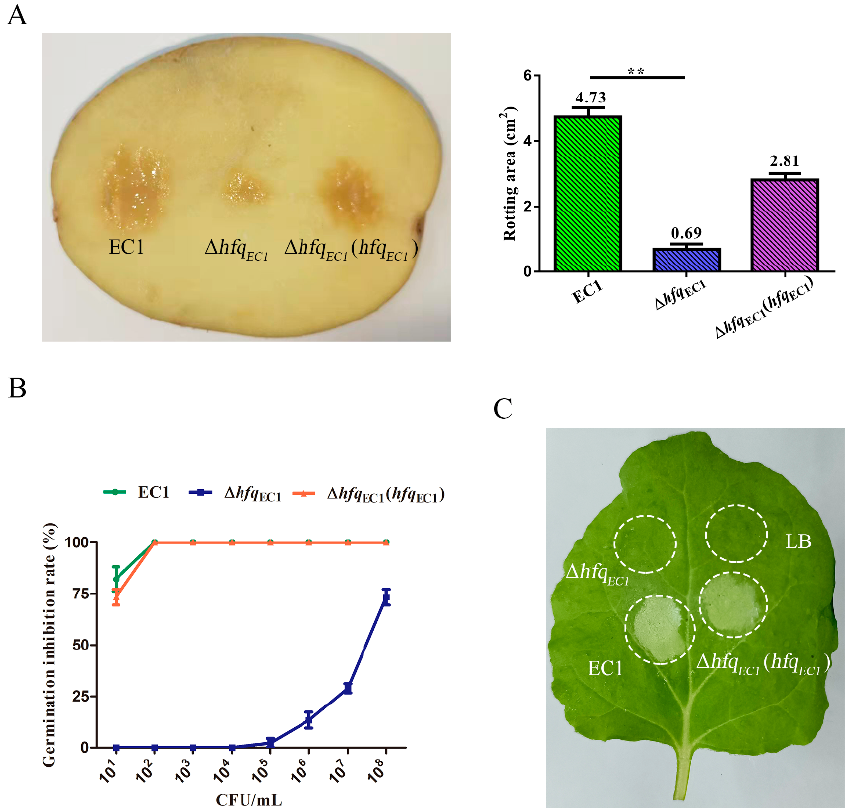
Figure 5. Hfq EC1 is required for the virulence and hypersensitive response (HR) in Dickeya oryzae EC1. ( A ) Disease symptoms (left) and the rotting areas (right) on potato tubers inoculated with wild-type strain EC1, hfq EC1 mutant, and complementation strain of hfq EC1 mutant. Photograph was taken 2 d after inoculation. The numbers at the top of each column show the average rotting area ± SD from three repeats. ** p < 0.01. ( B ) Analysis of the capacity of D . oryzae EC1 in inhibiting rice seed germination. Rice seeds were treated with different bacterial dilutions as indicated and incubated at 28 °C for 7 days. Experiments were individually performed at least three times in triplicate. ( C ) The hypersensitive response induced by wild-type strain EC1, hfq EC1 mutant, and complementation strain of hfq EC1 mutant on leaves of Nicotiana benthamiana . An aliquot of 5 µL of bacterial cell cultures (OD 600 = 0.05, 2.0 × 10 4 CFU/mL) was inoculated. The photograph was taken 24 h after infiltration.